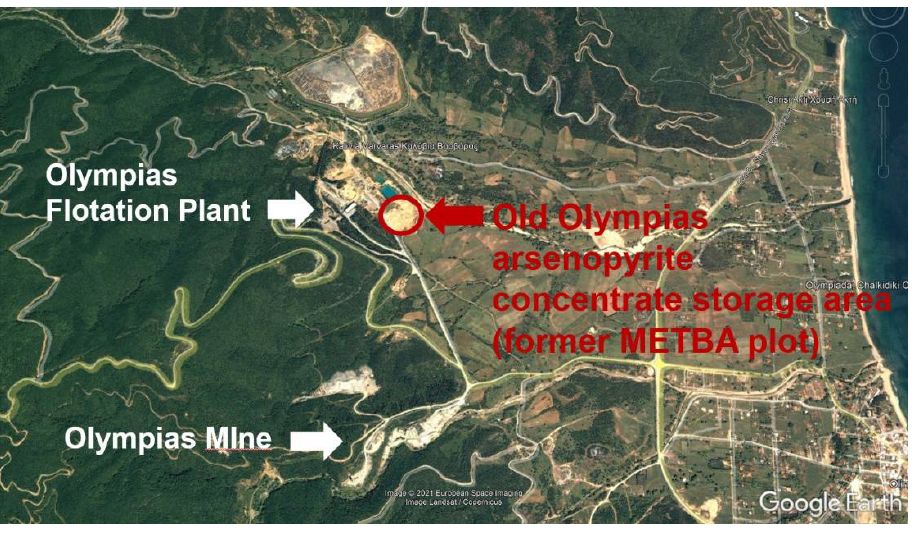
Figure 1. Old arsenopyrites concentrate storage area (former METBA plot) at Olympias, Halkidiki (2004).